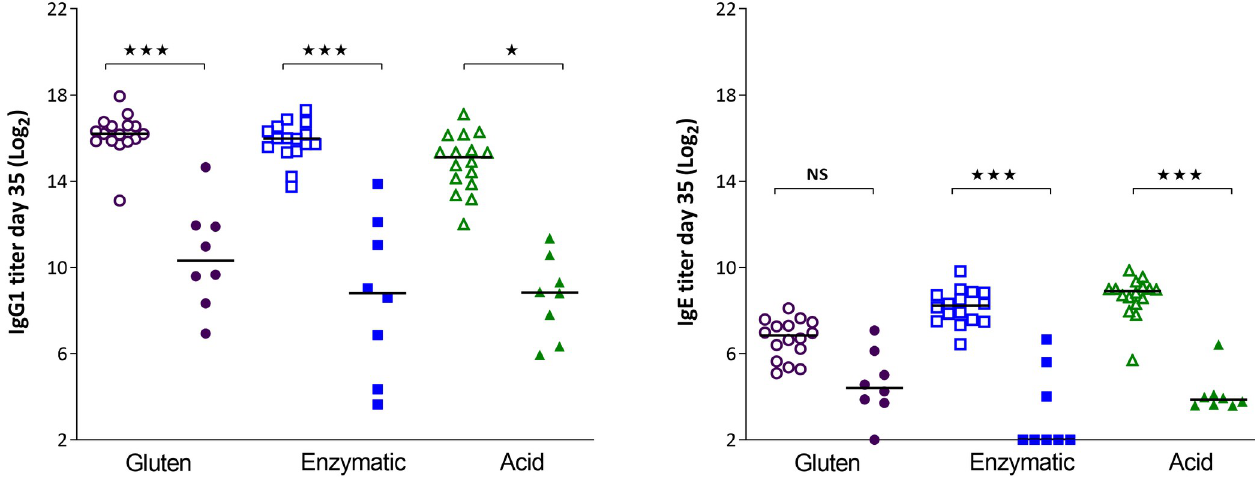
Fig 2. Specific antibody responses in gluten na ï ve rats (open symbols) and gluten tolerant rats (closed symbols) day 35 after three i.p. immunizations with gluten, enzyme or acid hydrolyzed gluten. � p < 0.05, ��� p < 0.001.